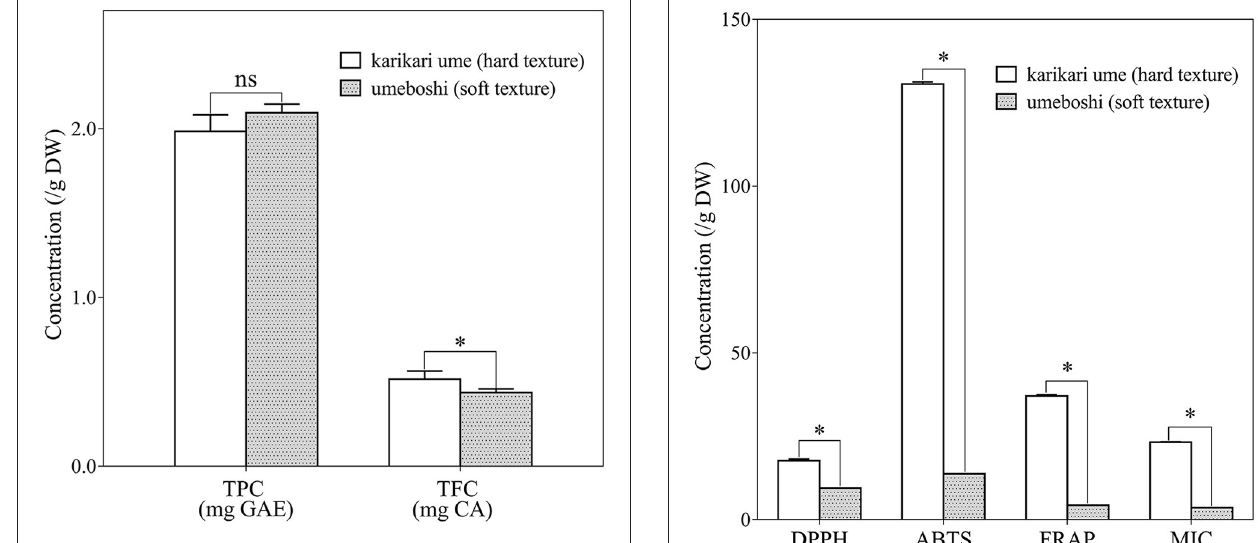
FIGURE 2 | Total bioactive compounds on total phenolic content (TPC) and total flavonoid content (TFC) in Karikari-ume (hard texture) and Umeboshi (soft texture) by microtiter plate assay, no statistical significance (ns), * p < 0.05 ( n = 3).